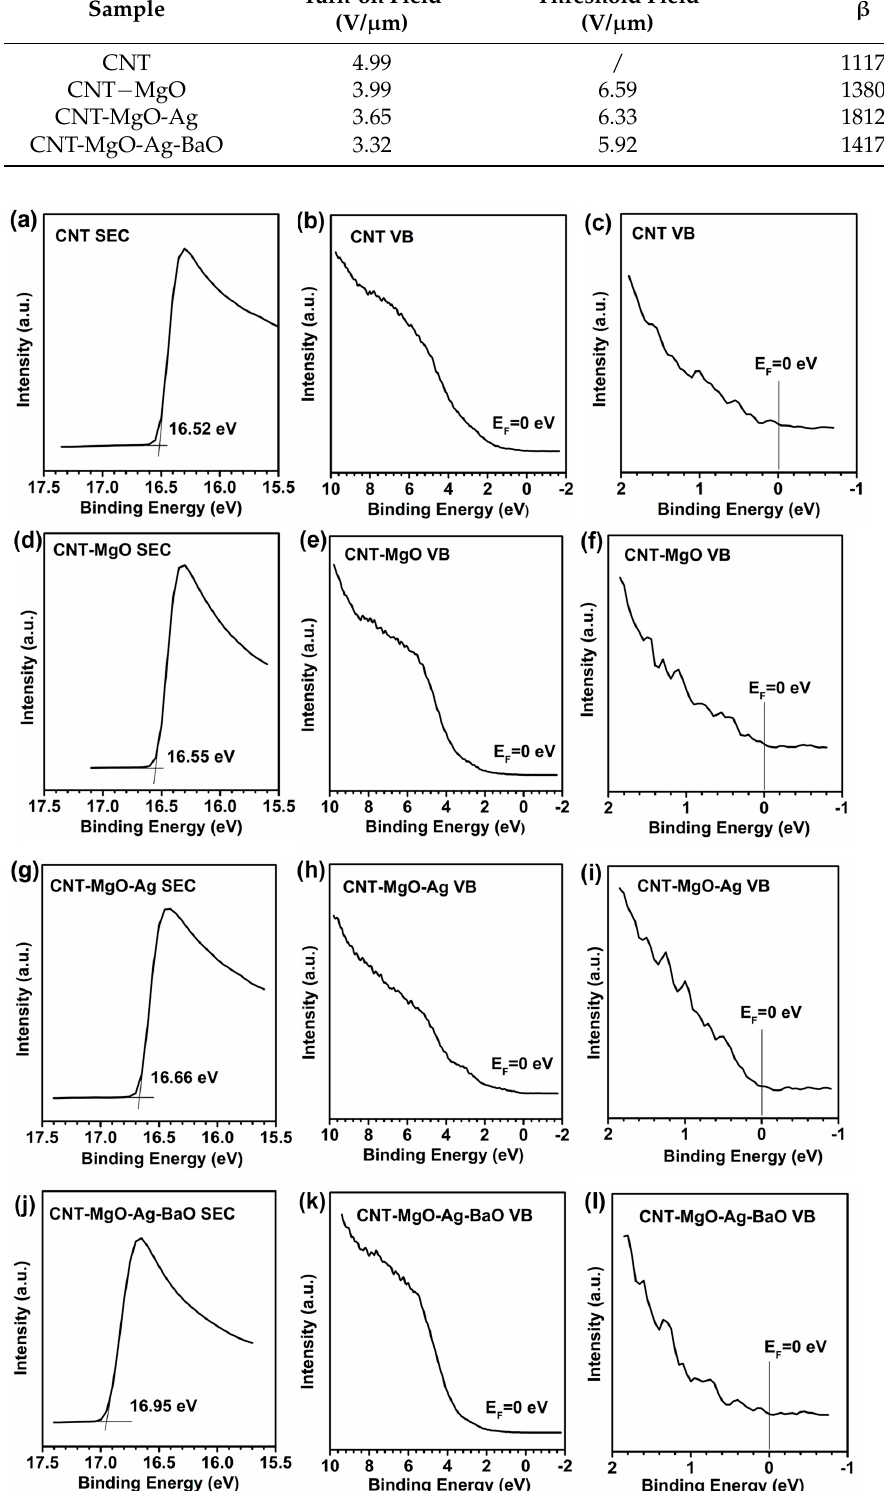
Figure 6 . UPS measurements of ( a – c ) the CNT, ( d – f ) CNT-MgO, ( g – i ) CNT-MgO-Ag, and ( j – l ) CNT-MgO-Ag-BaO composite samples. Note: SEC is the secondary electron cutoff, VB is the va- lence band, and E F is Fermi